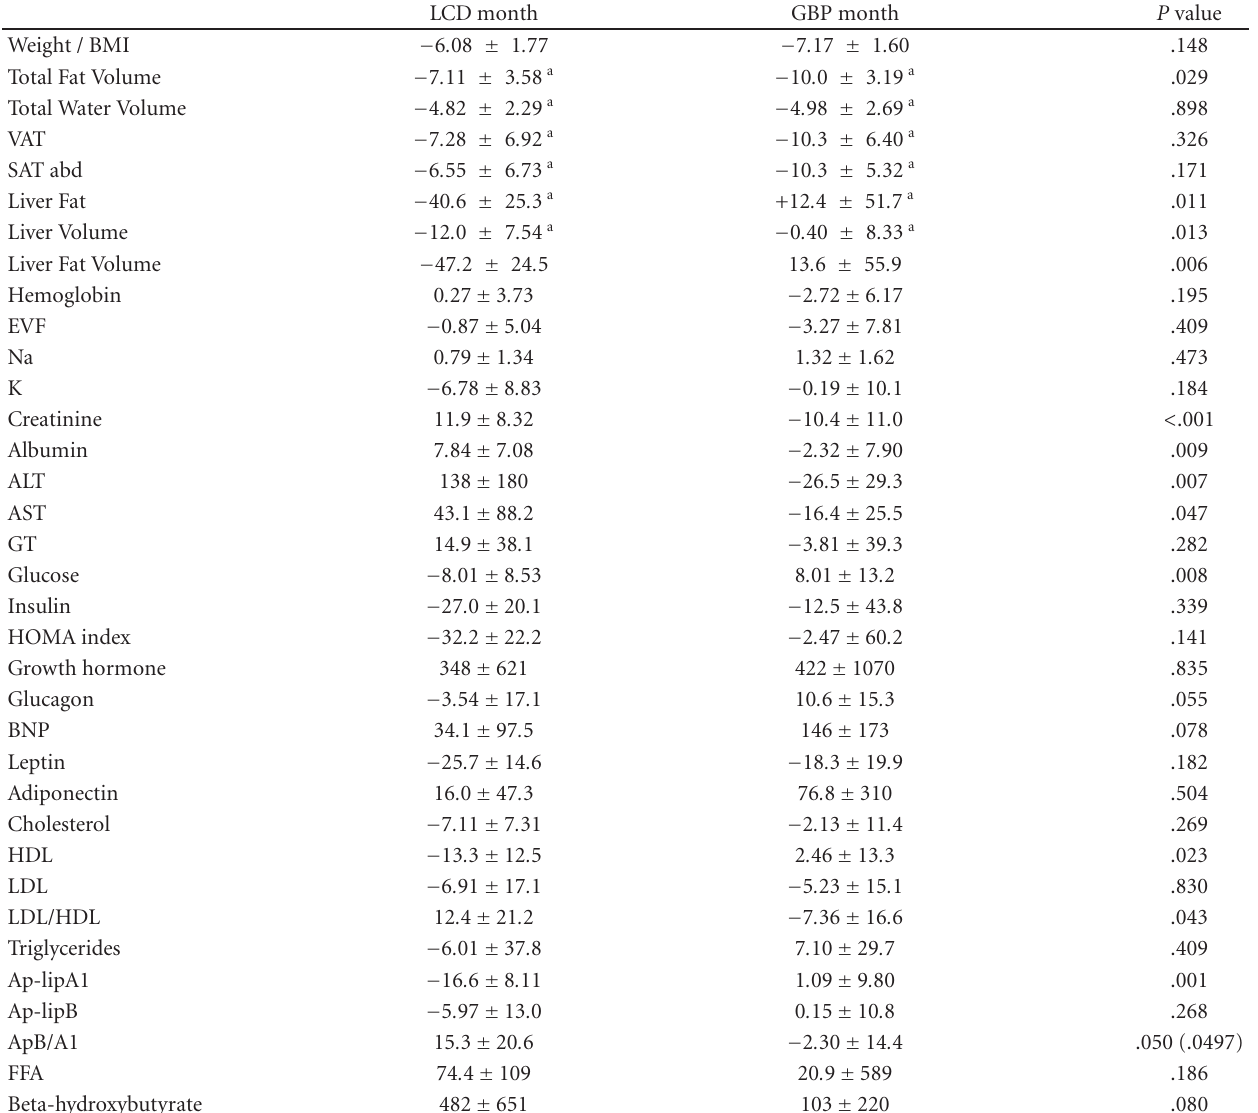
Table 2: Relative changes (%) over the low-calorie diet (LCD) and postGBP